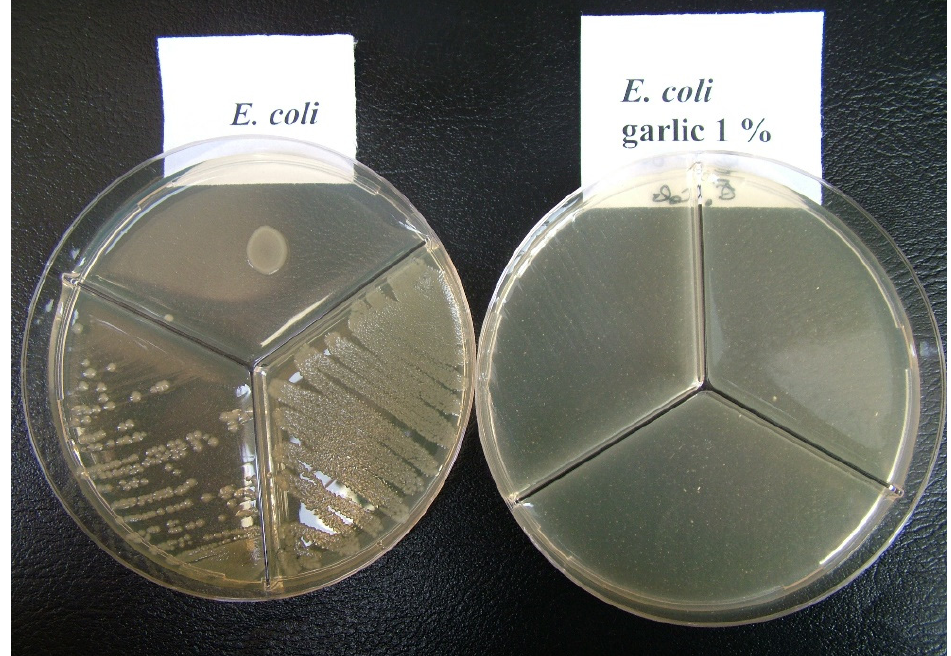
Figure 1. Escherichia coli (E. coli ). Left side: bacterial growth on the medium without garlic. Right side: total inhibition of growth in presence of 1% garlic.